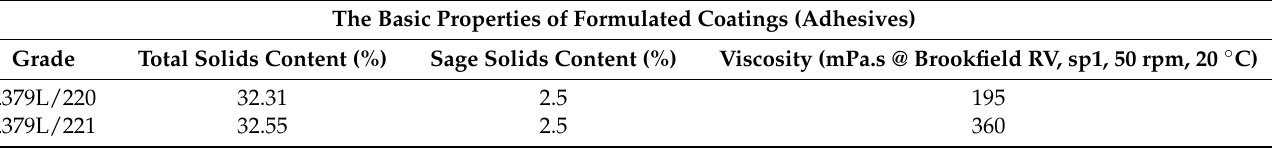
Table 1. The basic properties of the formulated coatings (adhesives) and six formulations of coated films. The Basic Properties of Formulated Coatings